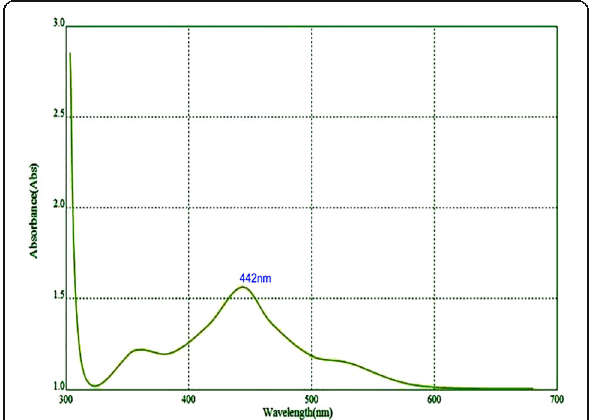
Fig. 2 UV-vis analysis of R. laetus -mediated AgNPs